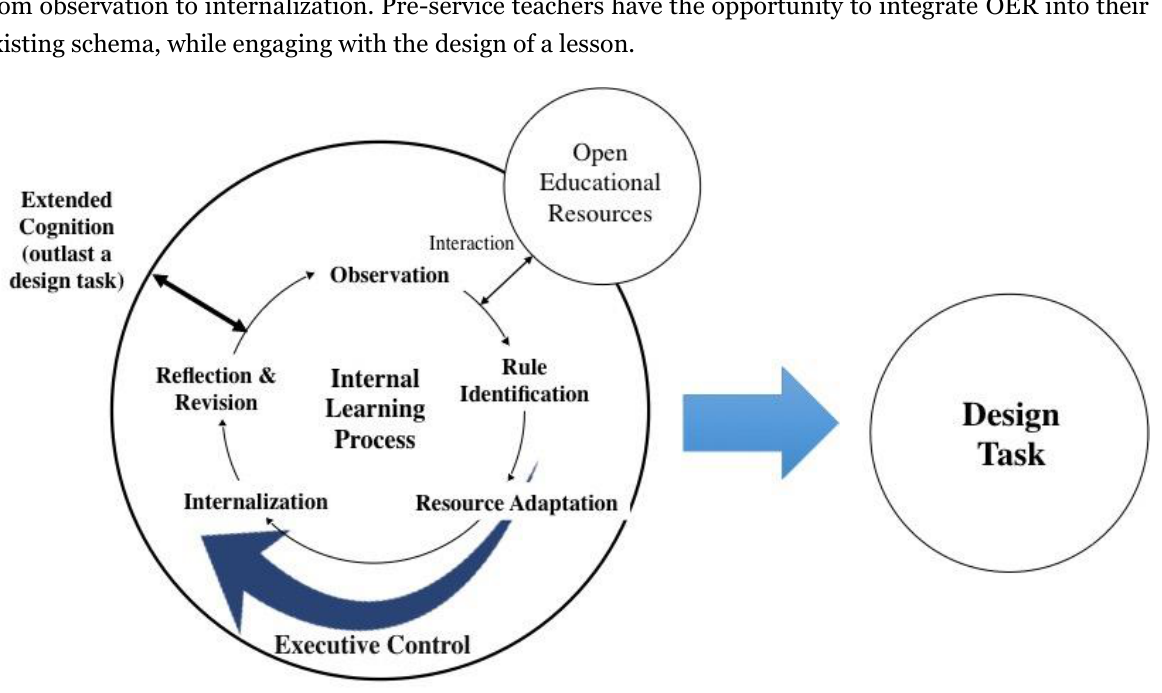
Figure 3. New framework for integrating OER into lesson